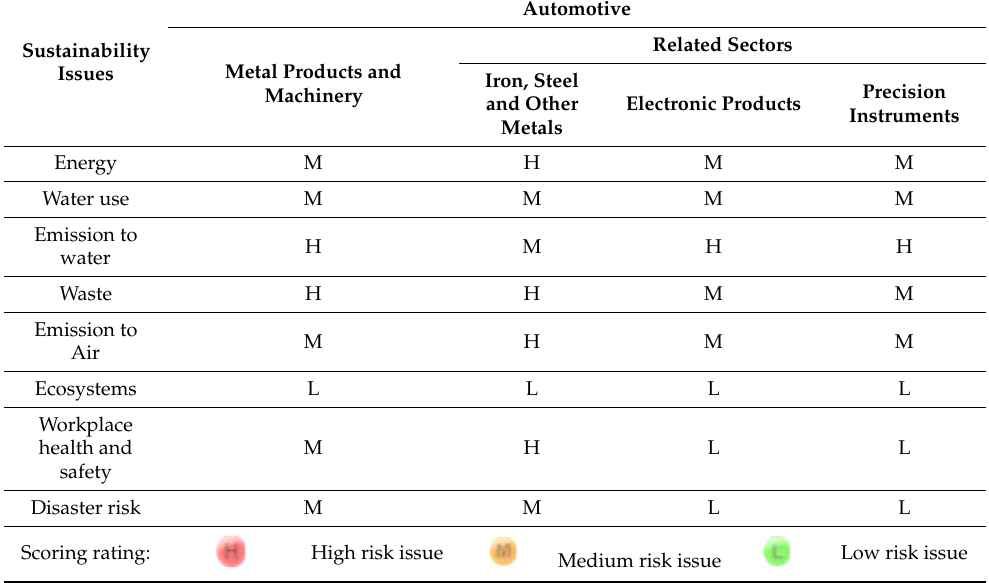
Table 6. Selected environmental and social risk associated with the automotive industry.